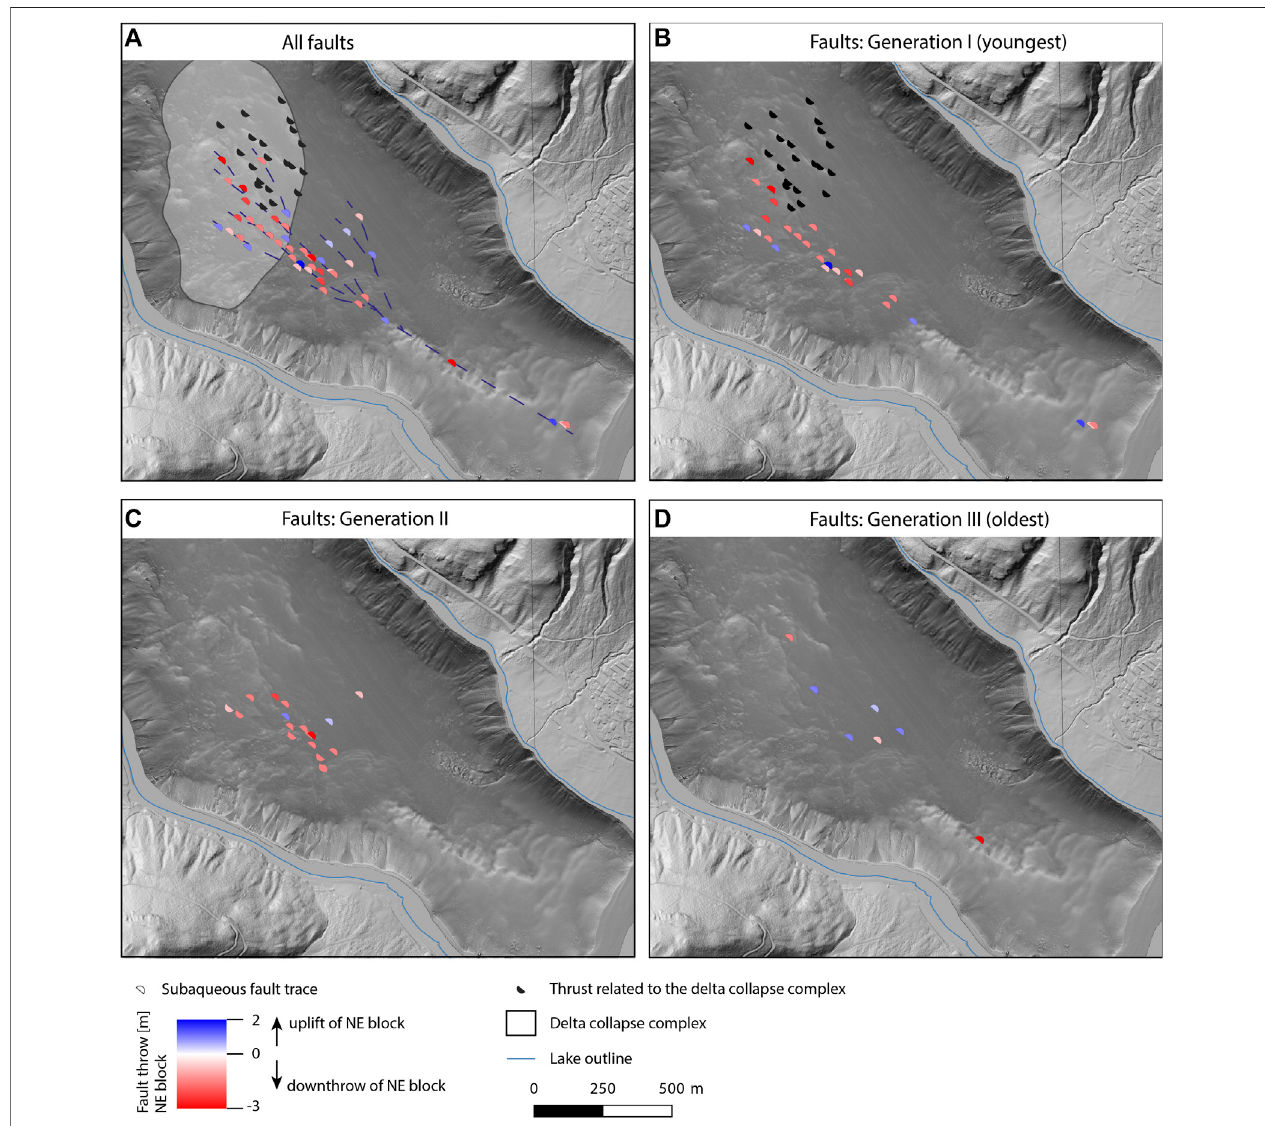
FIGURE 6 | (A) Subaqueous faults trace maps in the Pertisau basin colored with their respective fault throw, where a negative value de fi nes downthrow of the NE block in respect to the SW block and vice versa for positive values. Thrust faults related to the emplacement of the delta collapse complex (DCC) are colored black. A potential interpretation of interconnected fault traces is shown by dark-blue dashed lines. The individual fault generations I-III are distinguished in (B – D) based on the upper termination of the subaqueous faults in the stratigraphy (see also Figures 4A , 5 ).